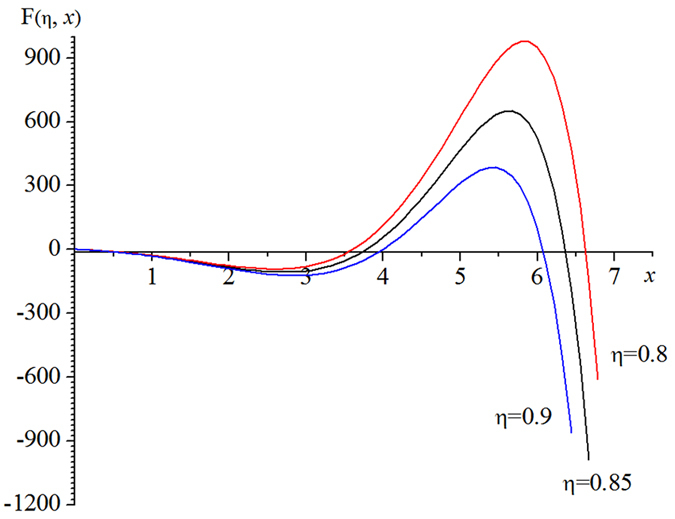
The curve of the left side of Eq. (6), when η = 0.8, 0.85, and 0.9.